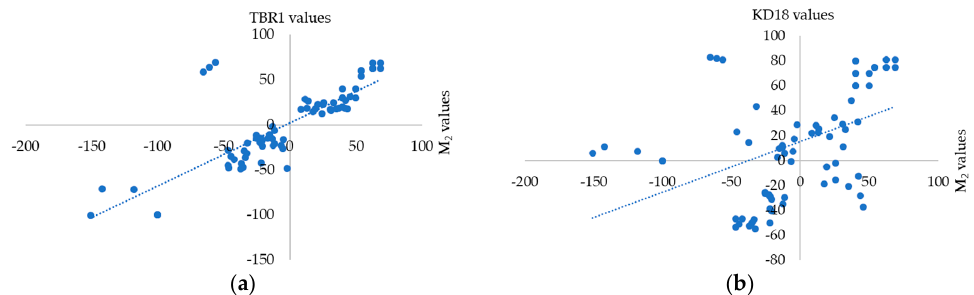
Figure 1. Distributions of phenotypic and chemical parameters between ( a ) M 2 and TBR1 (R 2 = 0.6494); ( b ) M 2 and KD18 (R 2 = 0.2059).